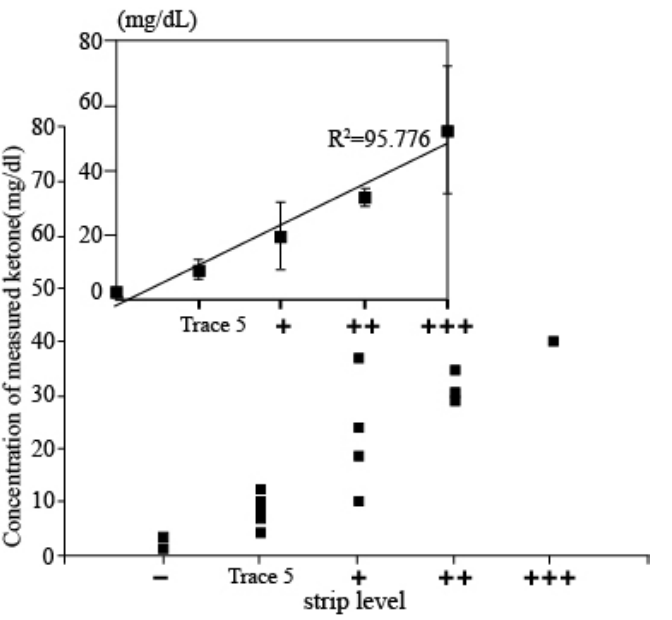
Figure 5. Associated plot between the electrochemical sensor and the dipstick methods acquired from 20 patients. x -axis presents ketone level detected by strip and y -axis shows ketone level measured by developed electrochemical sensor.